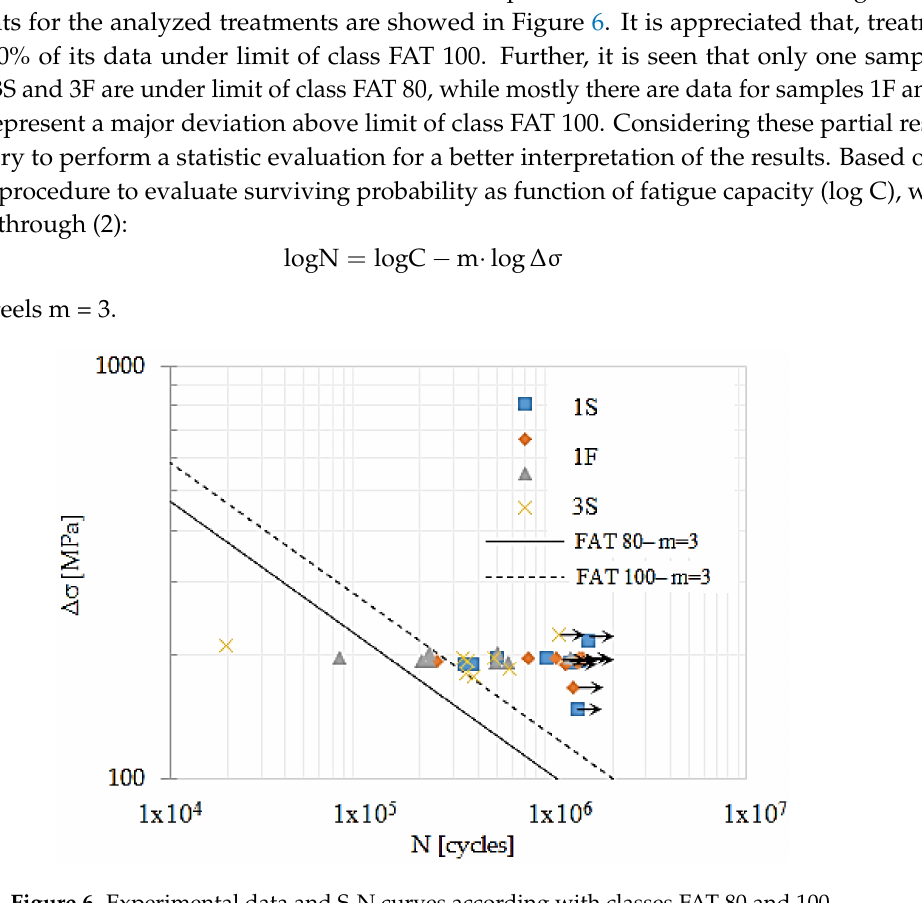
Figure 6. Experimental data and S-N curves according with classes FAT 80 and